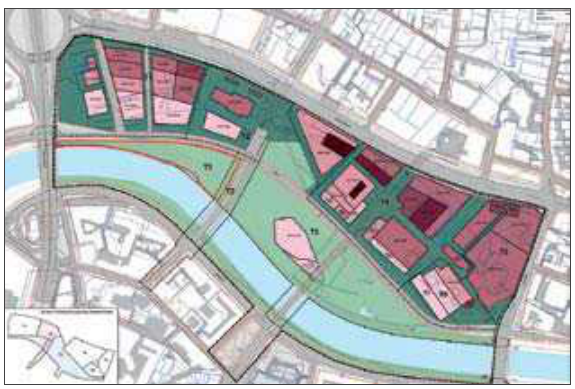
17 pav. Siūloma viešosios erdvės (archit. G. Čaikauskas) padėtis urbanistinėje konceptualaus planavimo schemoje („Vilniaus planas“, arch. S. Motieka) Fig. 17. Proposed location of public space (arch. G. Čaikauskas) in conceptual planning scheme (“Vilniaus planas”, arch. S.